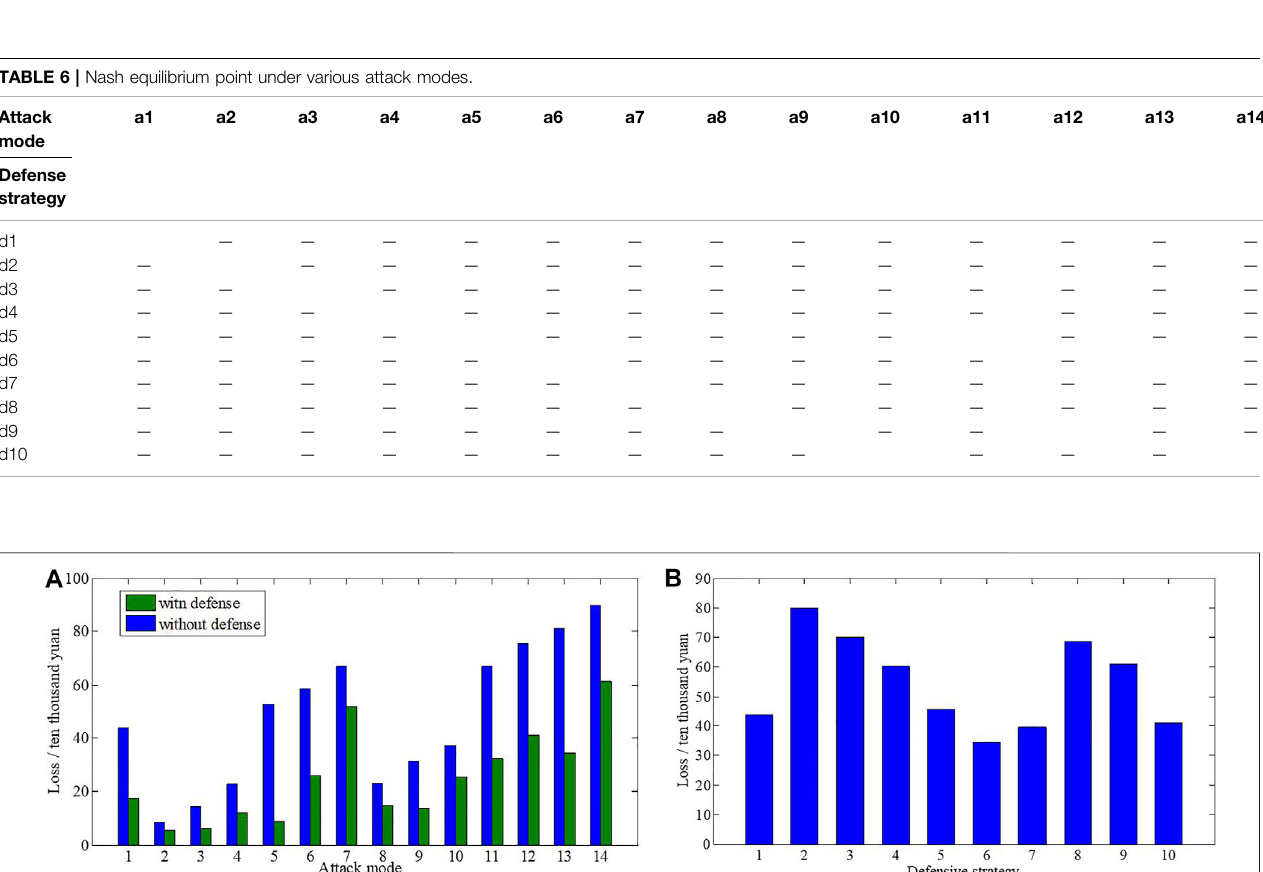
Frontiers in Energy Research |